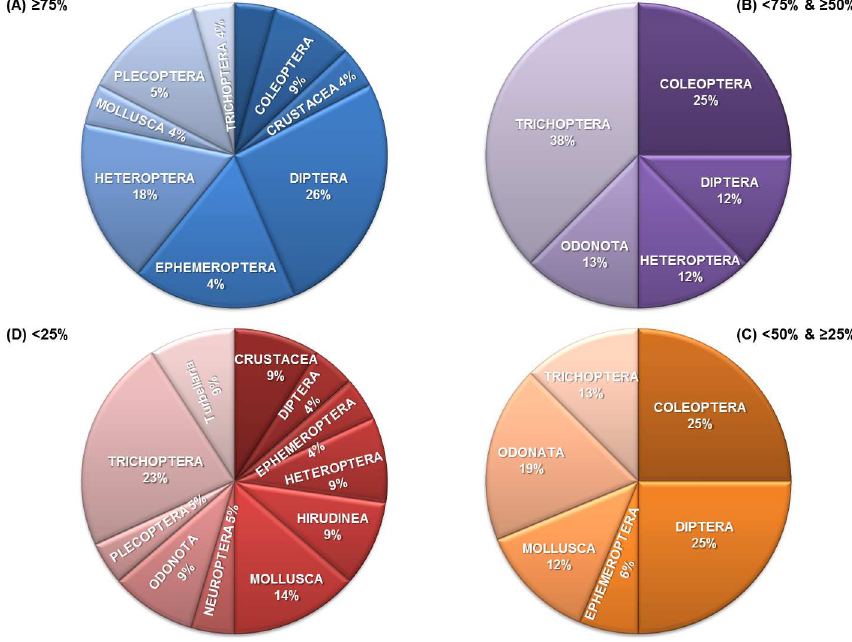
Fig 4. Percentage of taxa for each category of occupied area under current conditions (scenario 0). A (Blue): (cid:21) 75%; B (Purple): < 75 and (cid:21) 50%; C (Orange): < 50 and (cid:21) 25%; D (Red): < 25% of grids.